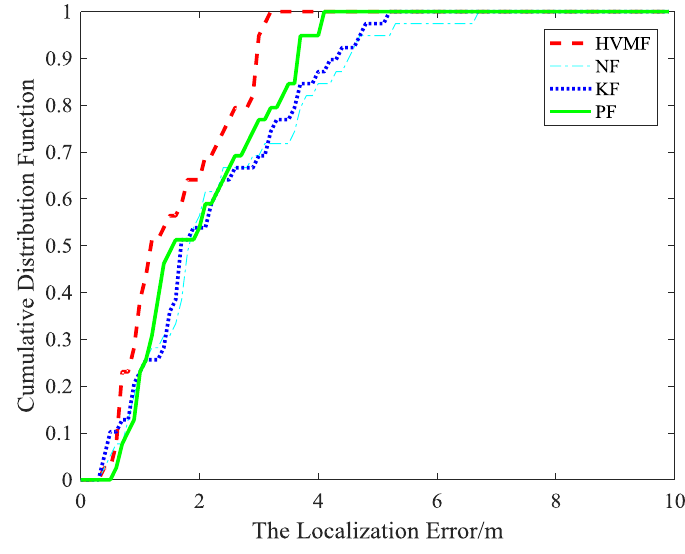
Figure 22. The localization error versus CDF